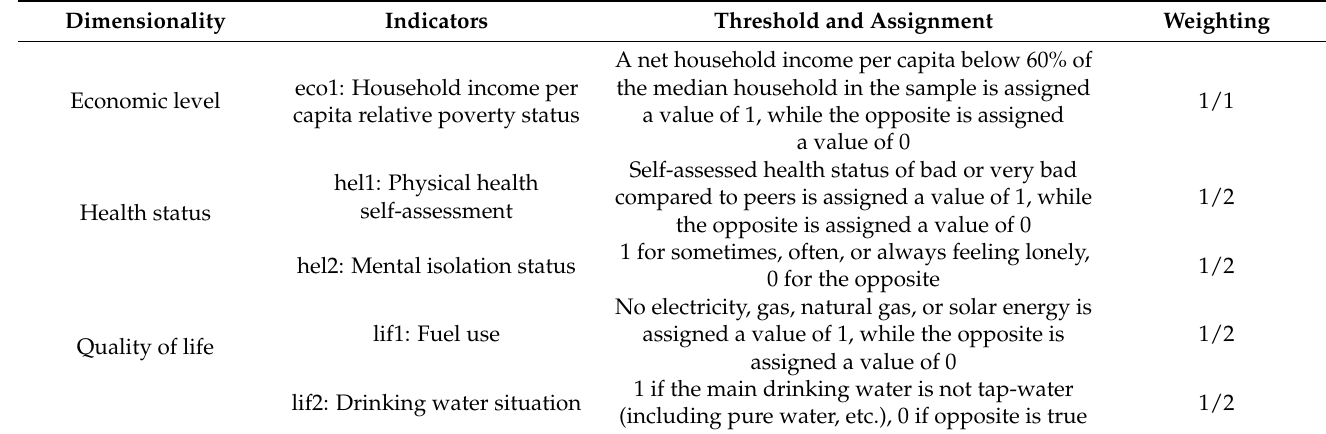
Table 1. Dimension, index, threshold, and weight